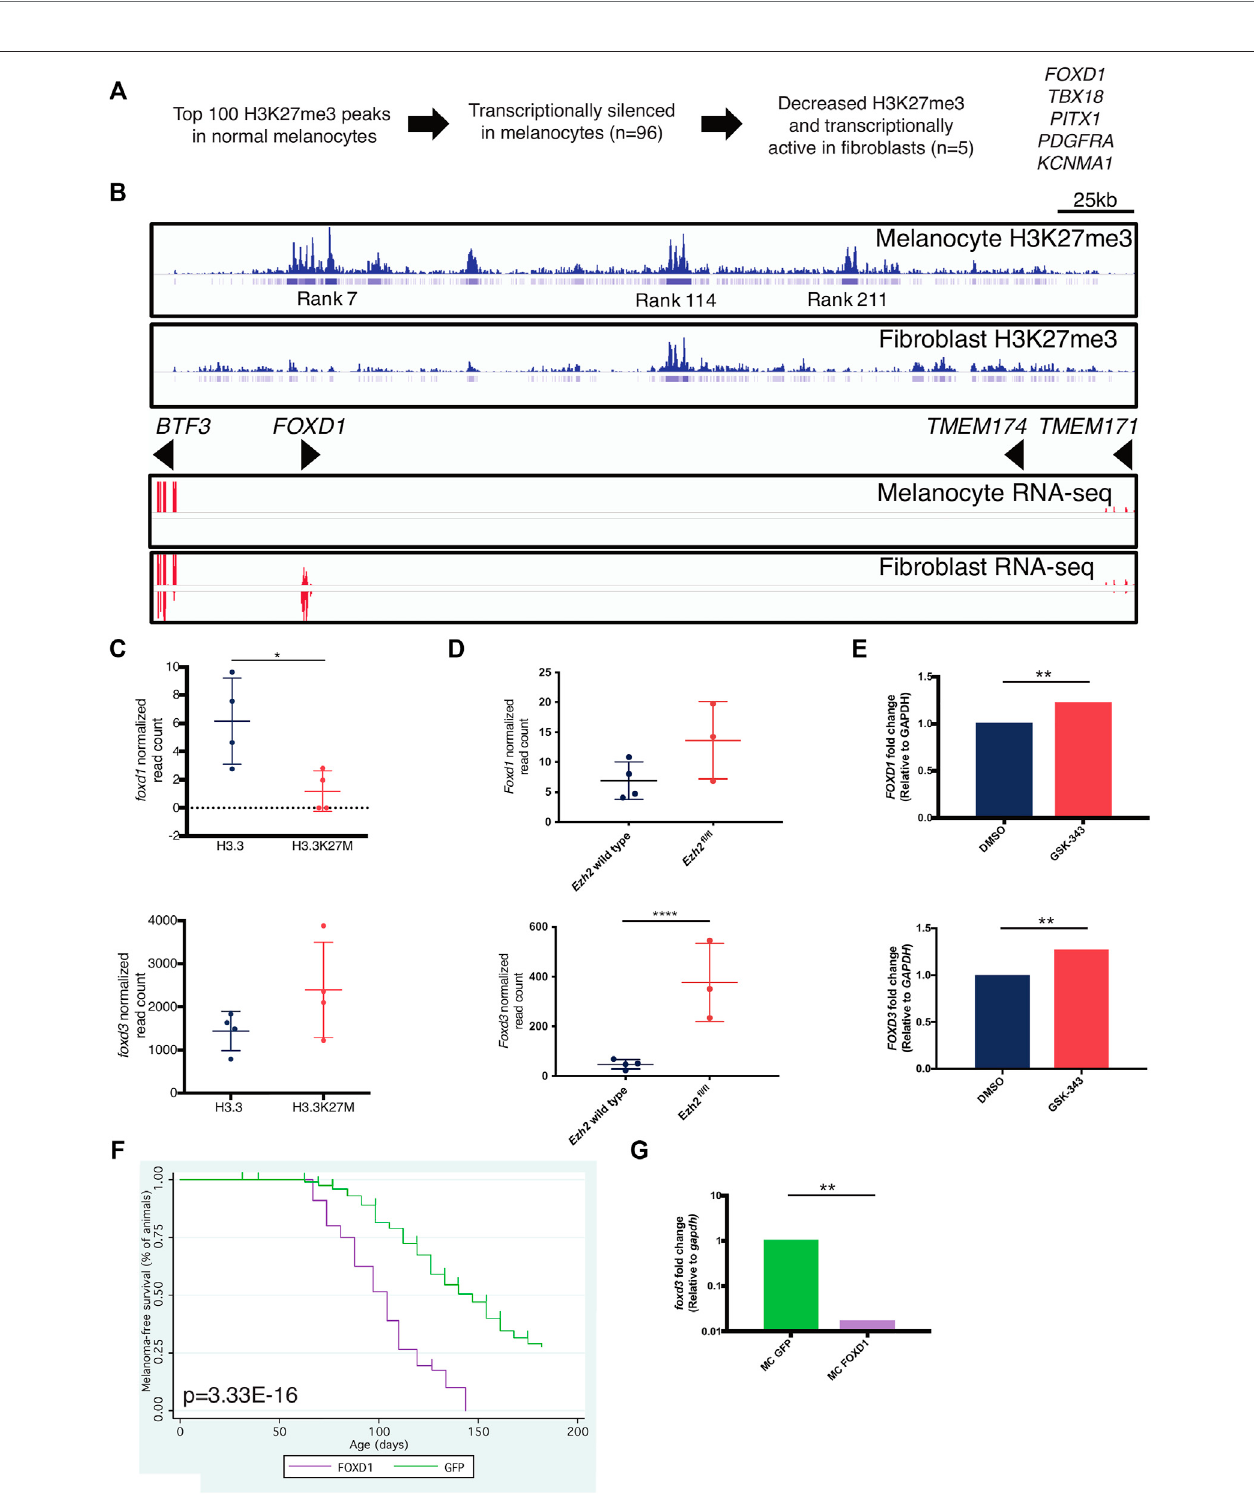
FIGURE 6 | FOXD1 is a PRC2 target gene in melanocytes. (A) Scheme to identify melanocyte-speci fi c PRC2 targets. (B) H3K27me3 (top) and RNA-seq (bottom) aroundtheFOXD1locusinmelanocytesand fi broblasts.Rankindicatestherankofenrichmentwithintheentiremelanocytegenomeie,rank7istheseventhhighestlevel of H3K27me3 enrichment in the melanocyte genome. (C) RNA-seq data of foxd1 (top) and foxd3 (bottom) levels within miniCoopR H3.3 and H3.3K27M zebra fi sh tumors. foxd1 , p = 0.0397, L2FC = − 1.33. foxd3, p = 0.101, L2FC = 0.656. (D) RNA-seq data of Foxd1 (top) and Foxd3 (bottom) levels in Ezh2 wild-type and Ezh2 fl / fl mouse tumors. Foxd1 , p = 0.185, L2FC = 0.853. Foxd3, p = 4.49E-11, L2FC = 2.81. (E) qPCR data of FOXD1 (top) and FOXD3 (bottom) levels in A375 human